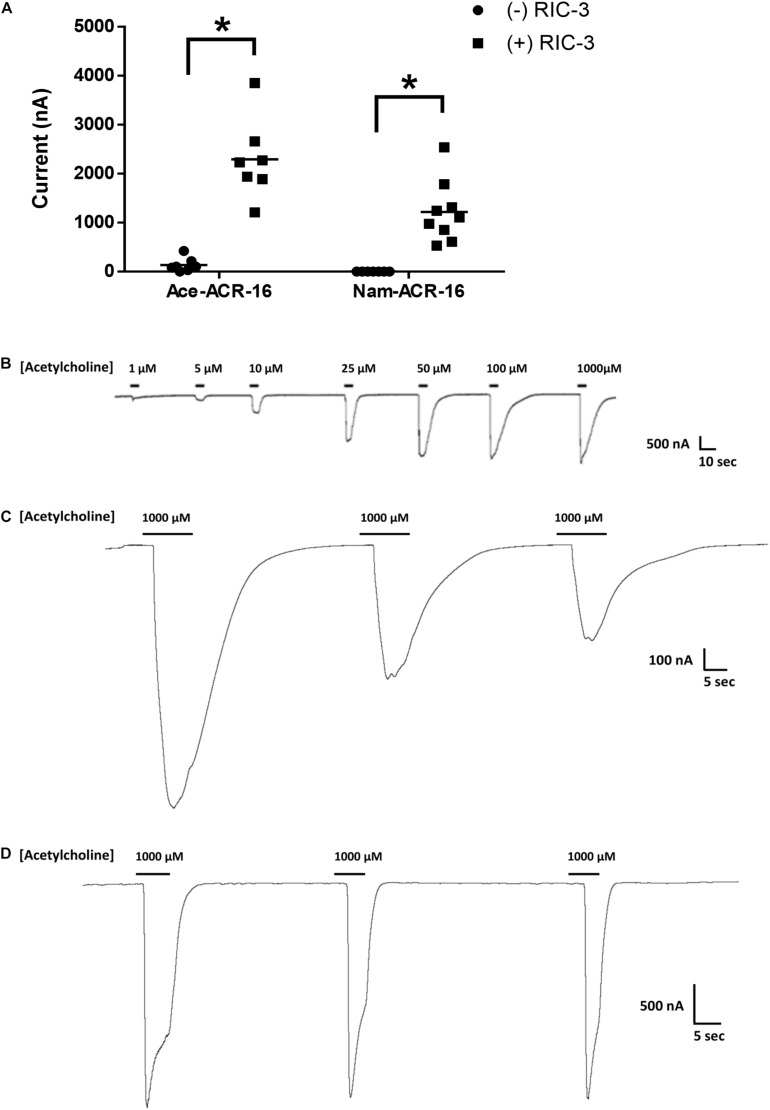
Functional expression of ACR-16 receptors in response to acetylcholine. (A) Amplitude of current response to 1 mM acetylcholine in the presence or absence of the accessory protein RIC-3 48 h after injection. Each point represents recordings from individual oocytes. n > 7; p < 0.05. (B) Ace-ACR-16 response profile to increasing concentrations of acetylcholine. (C) Reproducibility of Nam-ACR-16 and (D) Ace-ACR-16 current response profile to repeated concentrations of acetylcholine. Nam-ACR-16 displays reduced current responses to repeated exposures to acetylcholine.